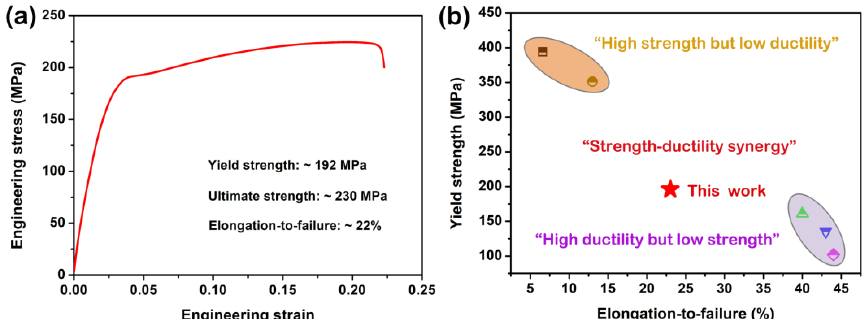
Figure 15. ( a ) Tensile engineering stress–strain curve of the as-extruded BX31 alloy; ( b ) relationship between the ultimate strength and the elongation-to-failure for this work (marked by red star) and the reported other Mg-Bi-Ca series alloys (labeled by different symbols). Note that orange and gray circles represent “high strength but low ductility” and “high ductility but low strength” regions, respectively. Reproduced with permission from Refs. [17–20]. Copyright 2020, 2022, Elsevier,